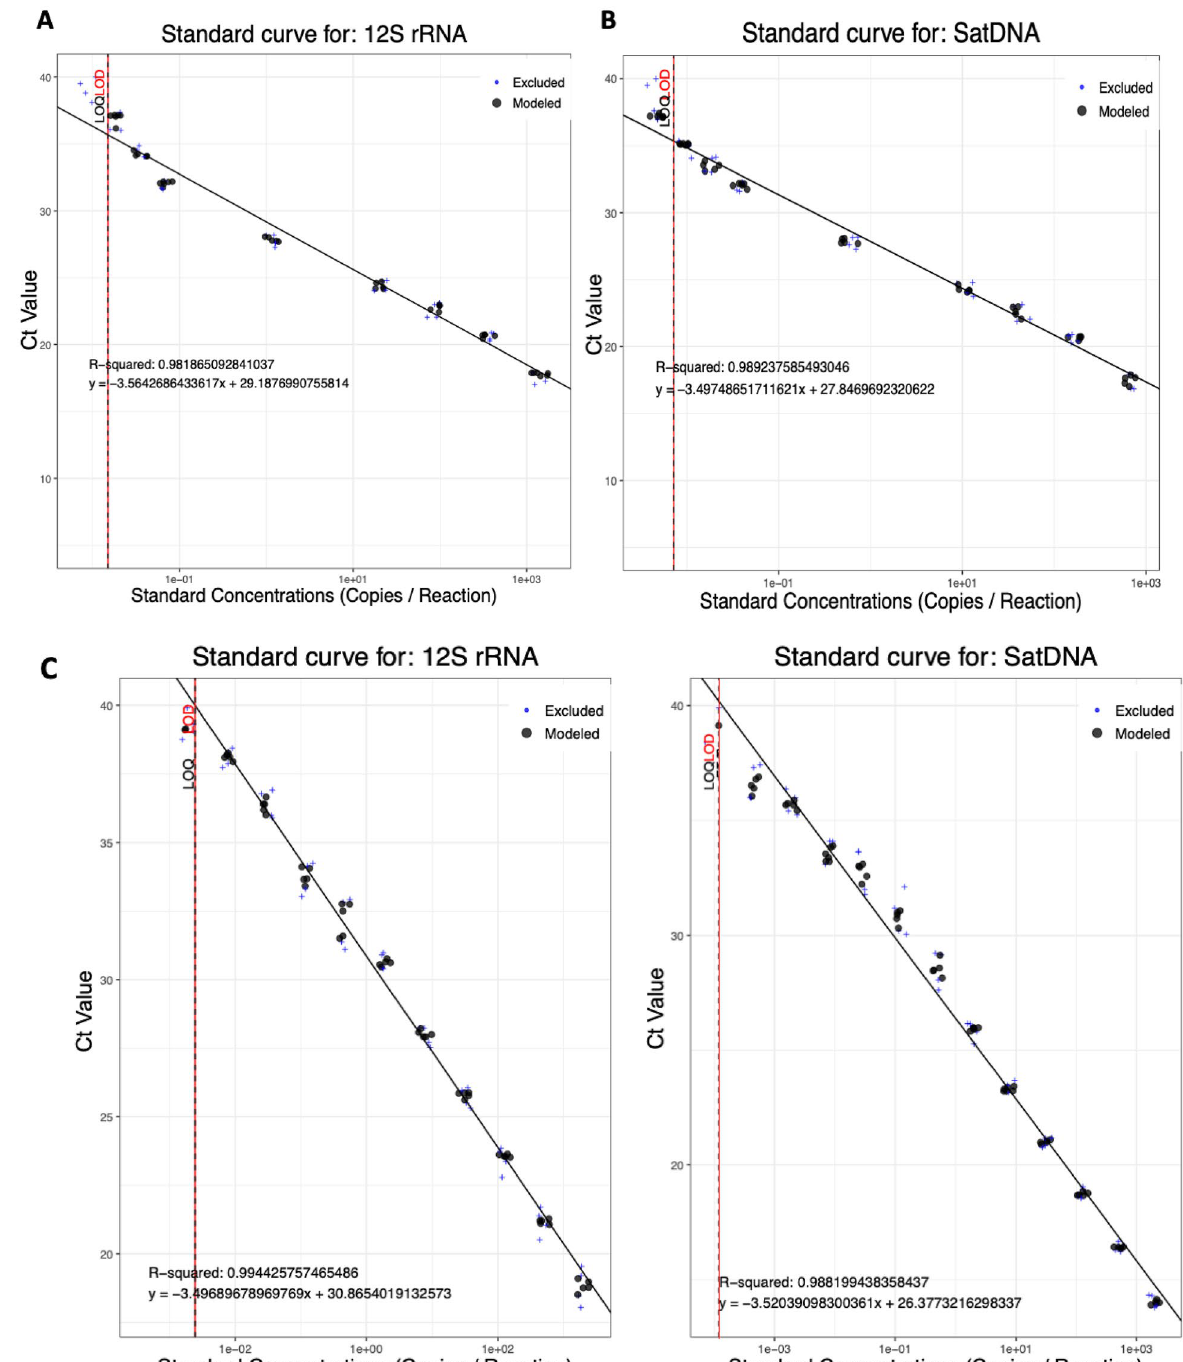
Figure 1. Standard curves for individual detection of R. prolixus 12S rRNA ( A ), T. cruzi satellite DNA ( B ) and simultaneous detection of R. prolixus 12S rRNA and T. cruzi satellite DNA ( C ), across serial gDNA dilution